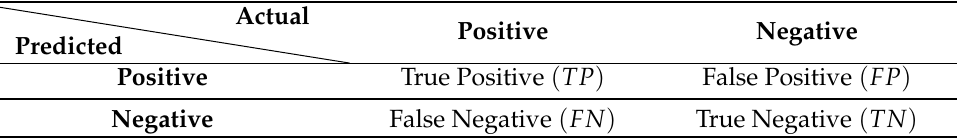
Table 3. Confusion